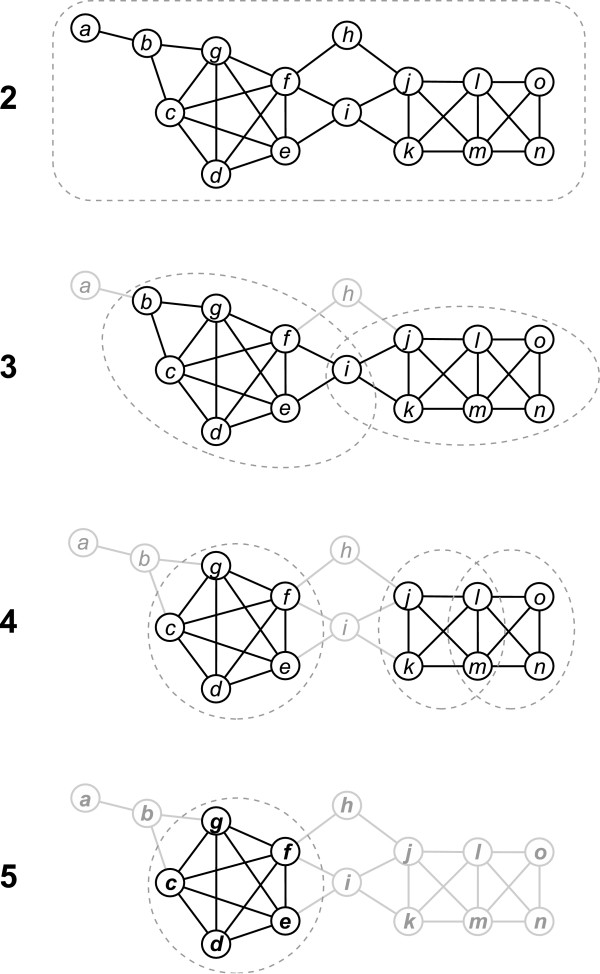
COGs at varying stringencies. The concept of stringency places a requirement of interconnectedness of elements of a COG. As stringency increases, COGs may split into smaller COGs and less-connected nodes are dropped. Each vertex represents a gene (as used in the initial definition of COGs) or an ORF (as used in this study). Edges represent bidirectional best-hit pairs. Dashed lines enclose elements of a single COG. Grayed vertices and edges do not participate in a COG at the given stringency. There is a single COG of stringency (2) containing all of the vertices in this graph because they are all transitively connected. Stringency (3) COGs are as described by Tatusov et al. [21]. An orthologous group of stringency 3 forms a triangle (such as {i , j , k }); orthologous groups of stringency (3) are clustered if they share two vertices (alternatively: if they share an edge). Stringency (4) OGs are clustered if they share three vertices. The orthologous groups {j , k , l , m } and {l , m , n , o } only share two vertices so they form two separate COGs. At stringency (5) only one orthologous group, and thus only one COG, remains.